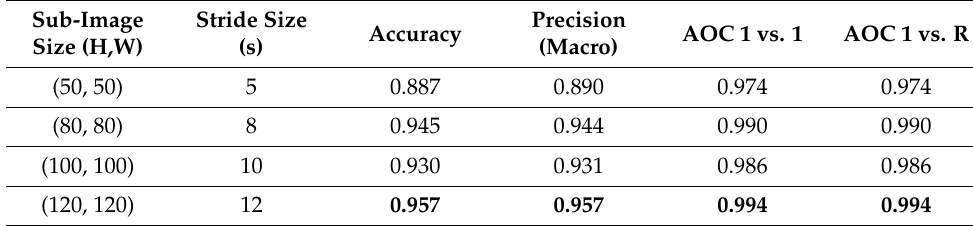
Table 2. Sub-image grove classification results for the validation set.